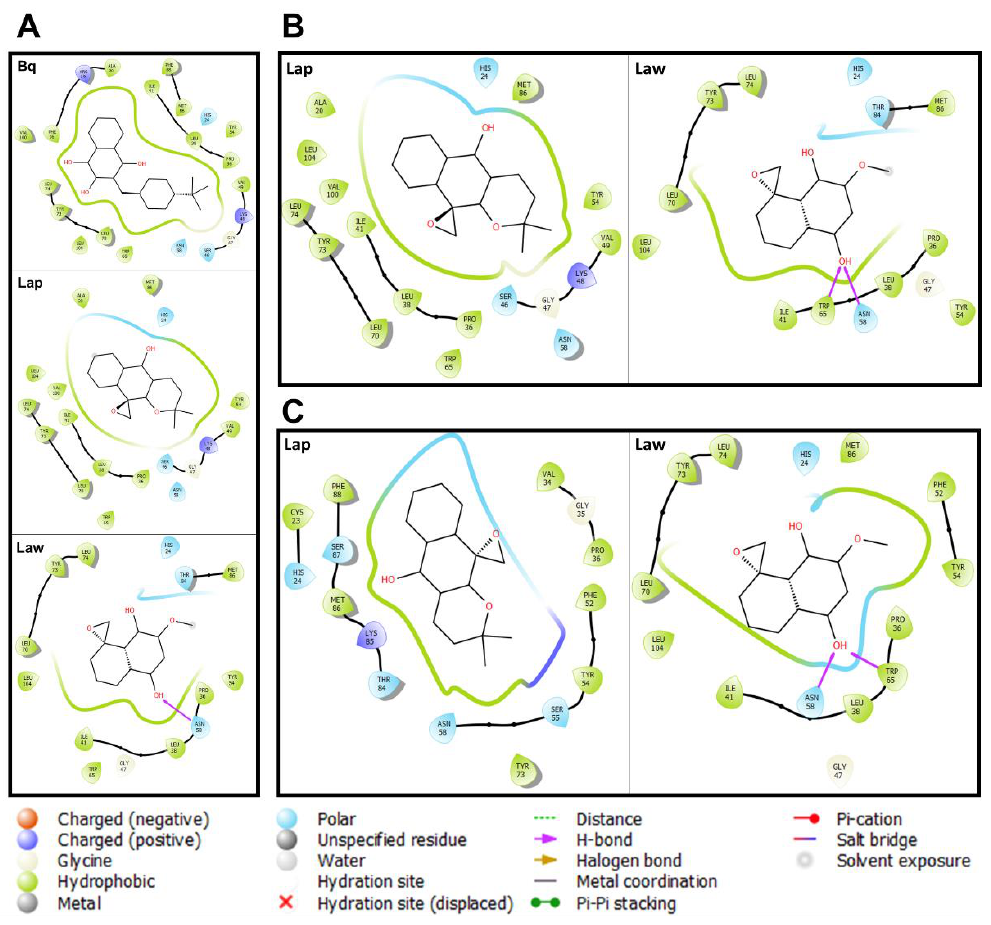
Figure 3. Molecular interaction of naphthoquinone derivatives with Leishmania spp. cytochrome c. Docking assays were performed with cytochrome c of L. ( L. ) major ( A ); L. ( L. ) amazonensis ( B ); and L. ( V. ) braziliensis ( C ). The 2D representation indicates the types of bonds that occur in cytochrome c with Buparvaquone (3-[(4-tert-butylcyclohexyl)methyl]-4-hydroxynaphthalene- 1,2-dione-BH), Epoxy- α -lapachone (2,2-dimethyl-3,4-dihydrospiro[benzo[g]chromene-10,20-oxiran]-5(2H)-one-Lap), and Epoxymethyl-lawsone